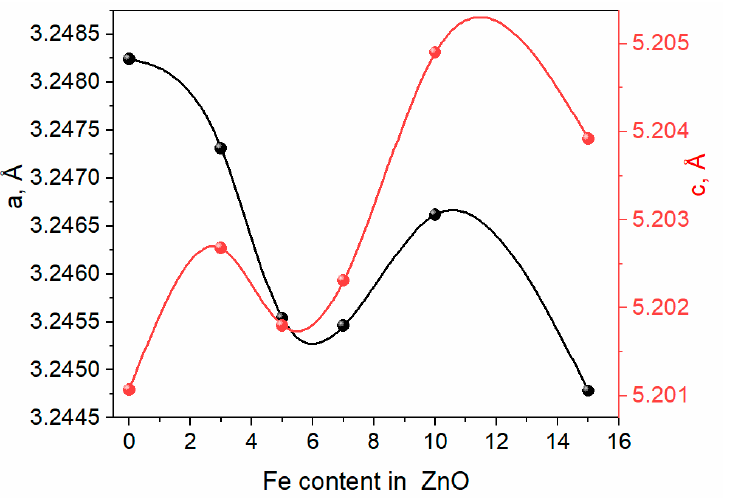
Figure 1. XRD patterns of Zn 1 − x Fe x O.